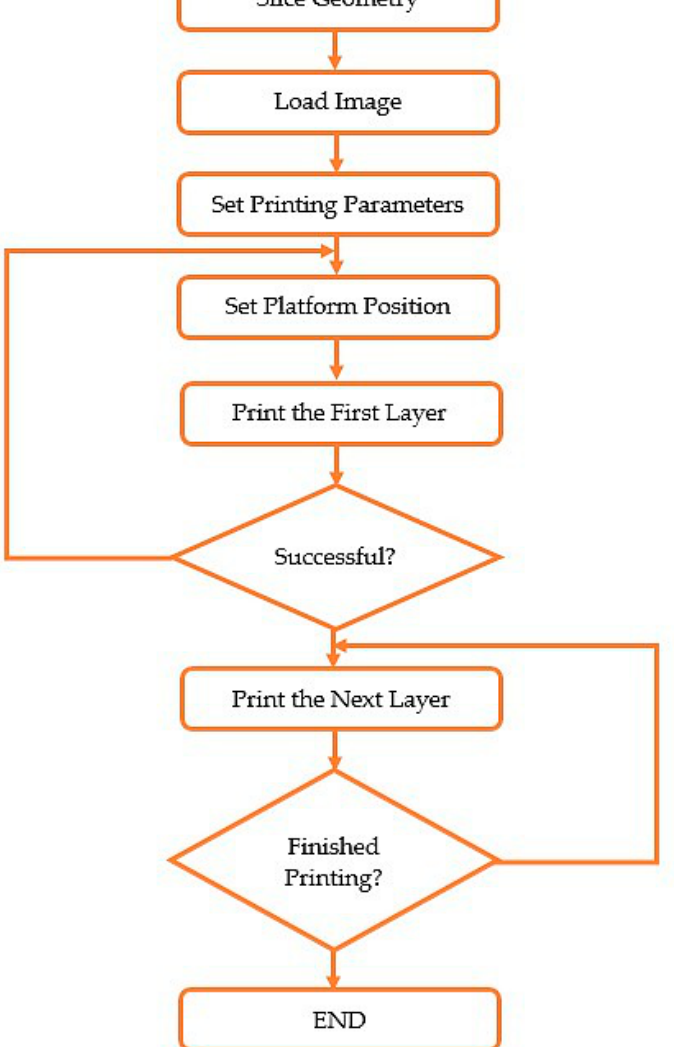
Figure 5. The step-by-step diagram of the 3D printing operation.